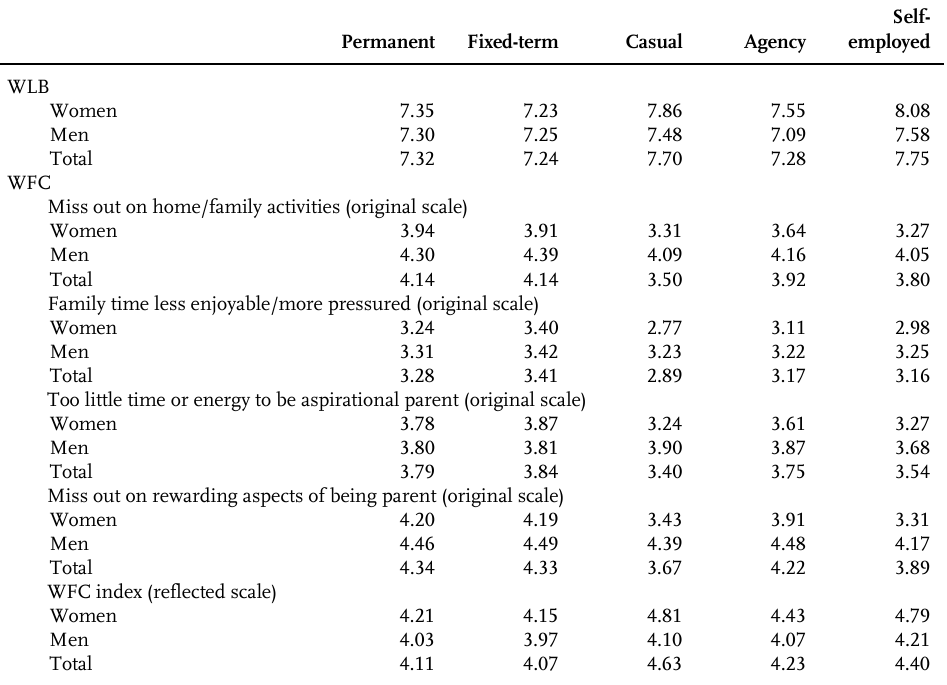
Permanent Fixed-term Casual Agency